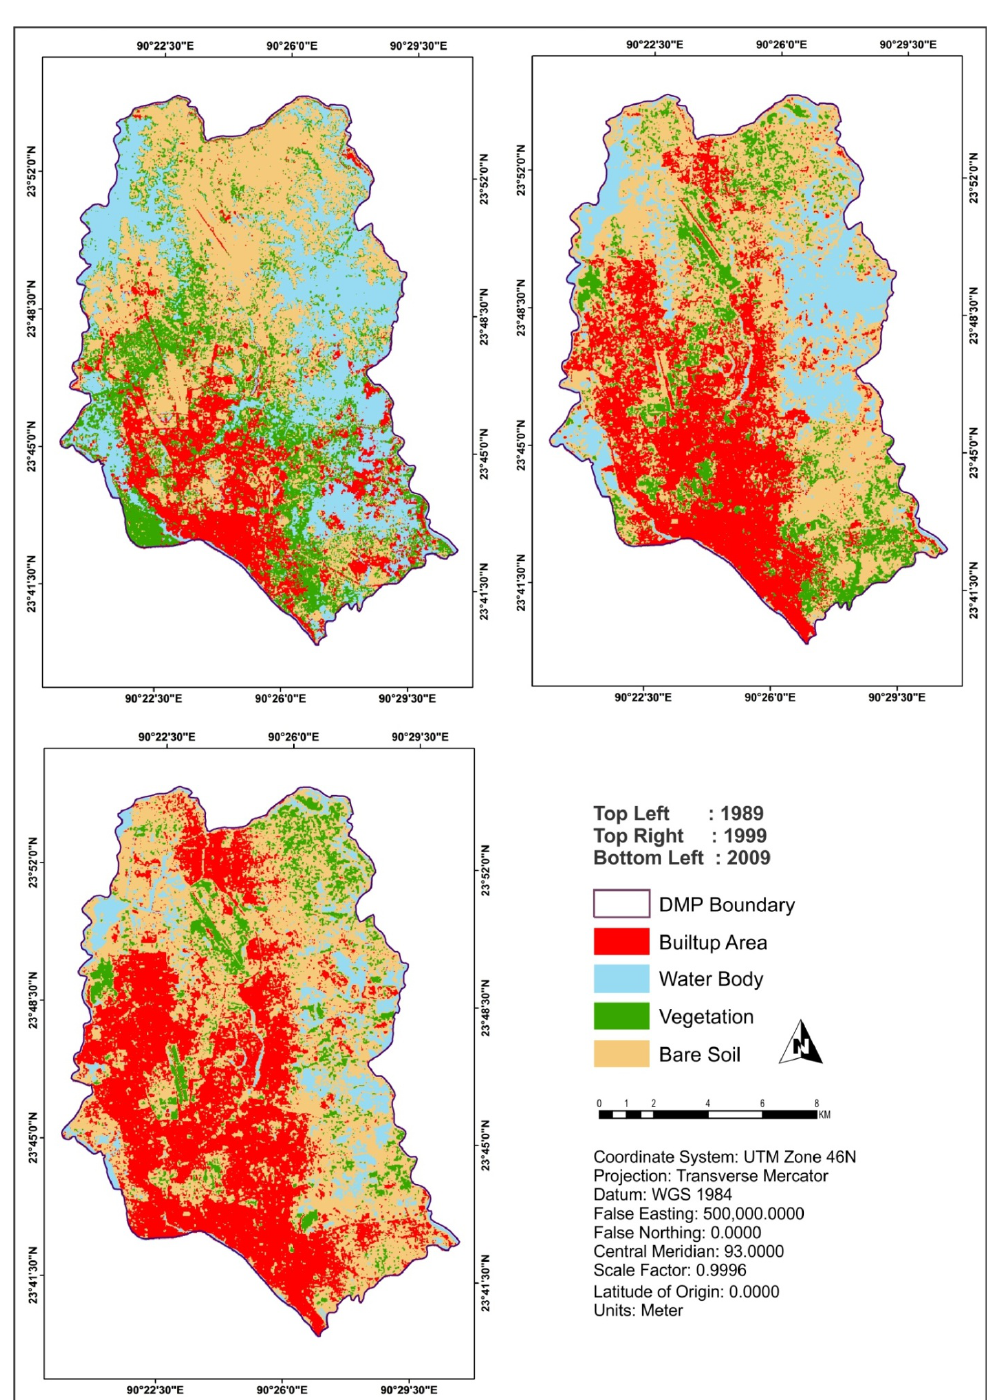
Figure 3. Land cover maps of DMP